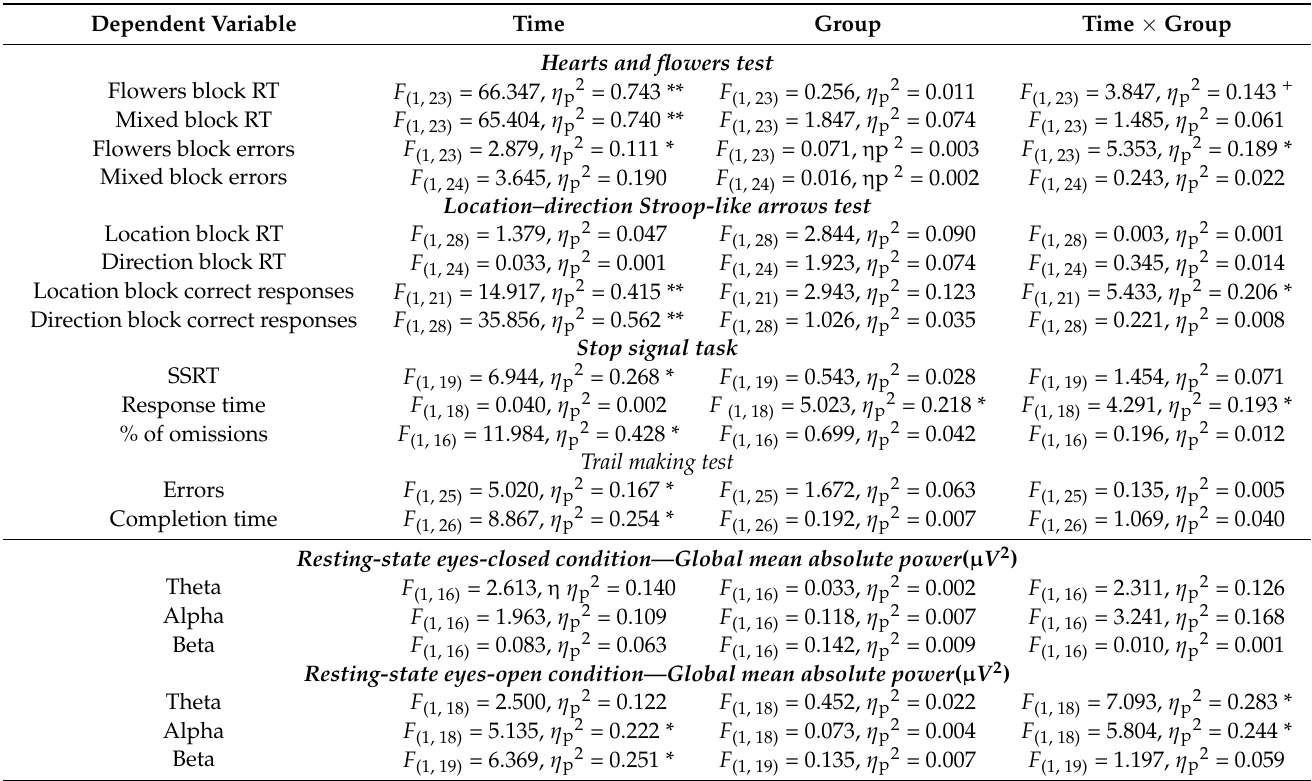
Table 2. Results of the repeated measures ANOVAs (model